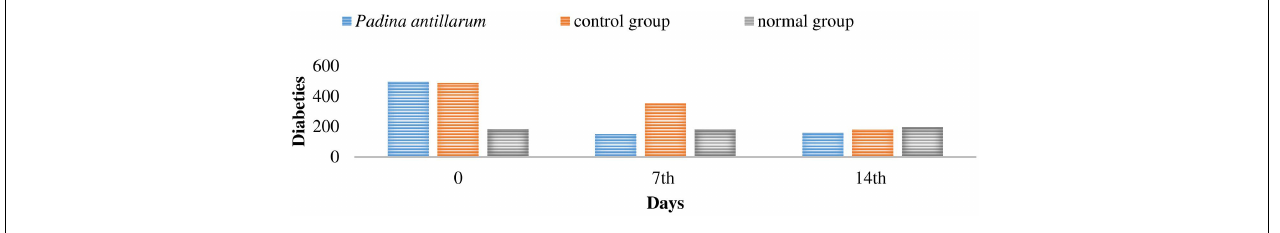
FIGURE 10 | The blood glucose level of the mices during the study. TABLE 5 | Effect of Padina antillarum extract on hematological parameters.